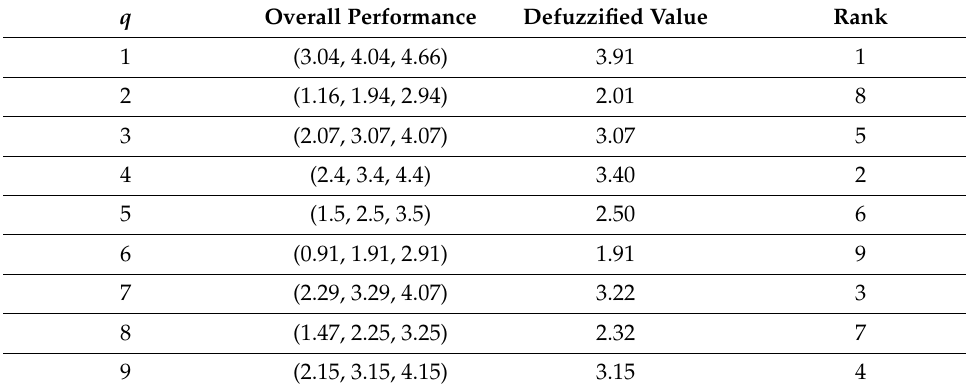
Table 9. Ranking results using